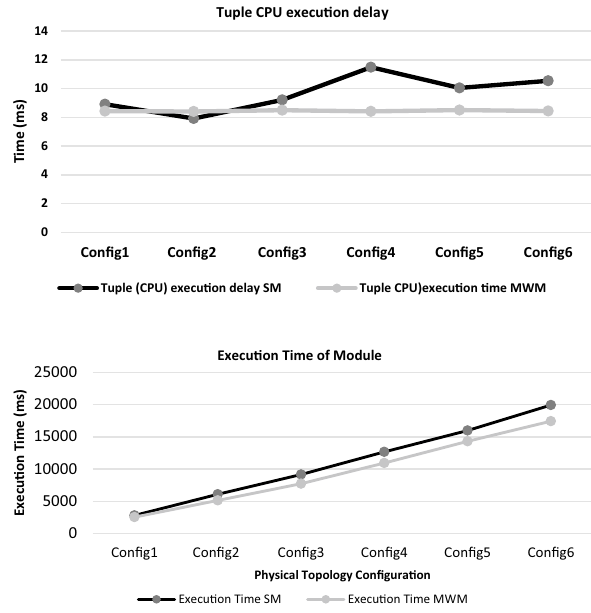
Fig. 10 The tuple CPU execu- tion delay for SM and MWM